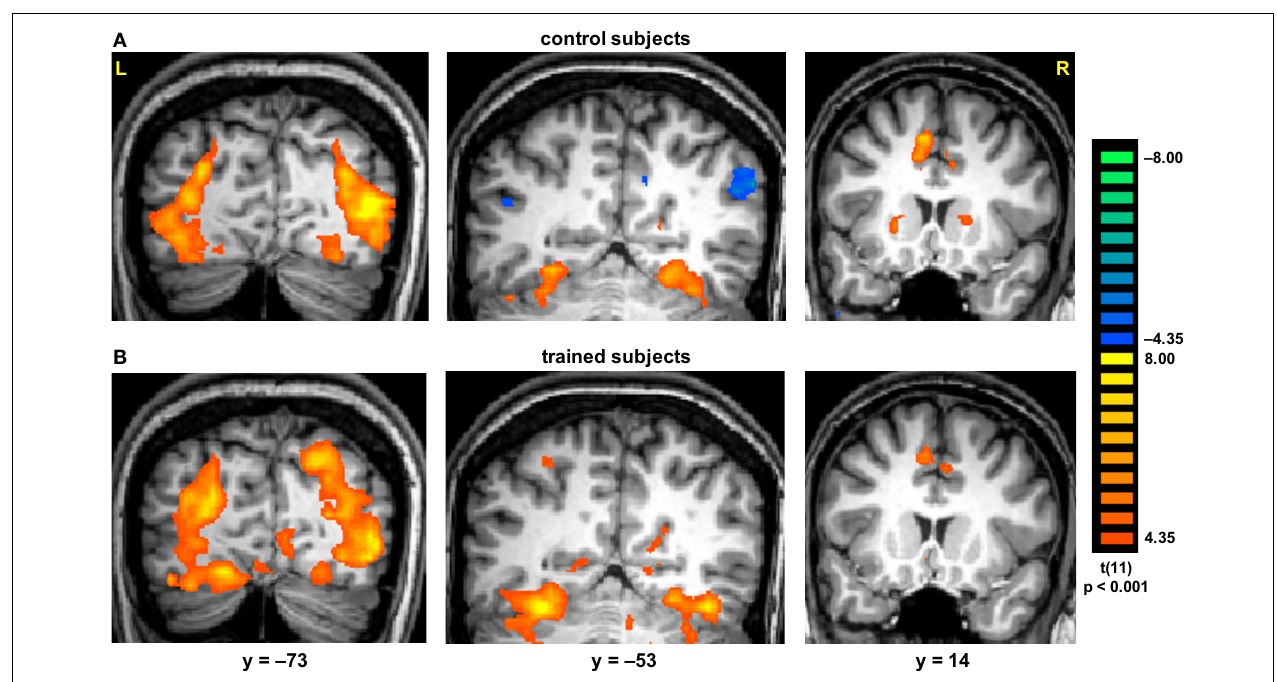
FIGURE 2 | Activation evoked by Cubist paintings as compared with scrambled images. Group statistical maps, illustrating signifi cant activation in DOC, FG, IPS, putamen and ACC are shown for control (A) and trained (B)